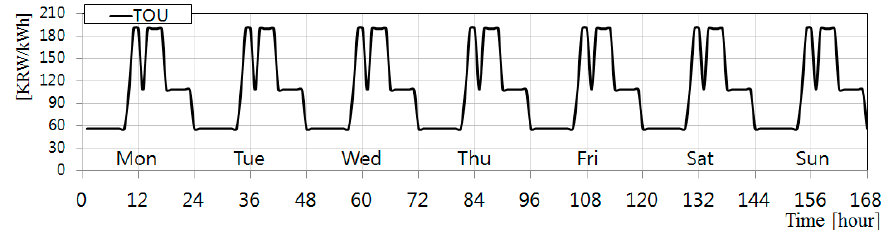
Figure 5. Customer’s energy rate (TOU) for a week.